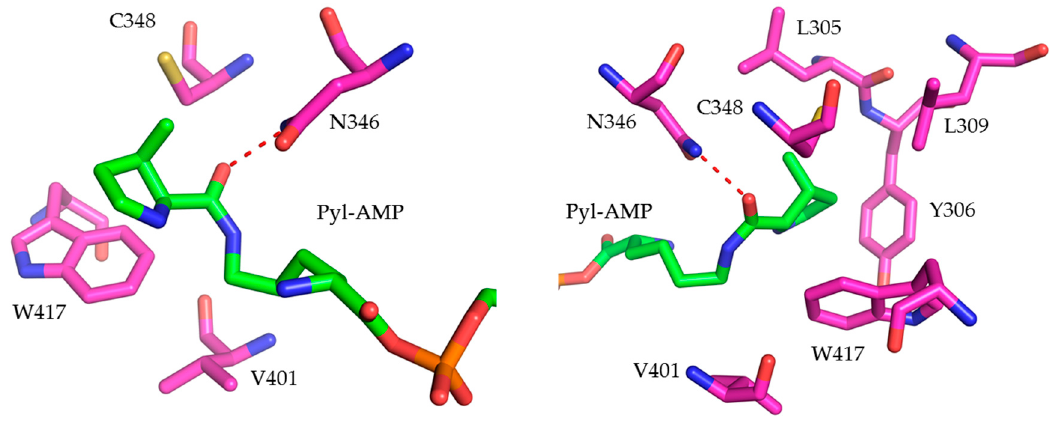
Figure 2. Key residues surrounding the active site pocket of Mm PylRS for amino acid substrate recognition (PDB: 2Q7H [10]). The distance between N346 and the bound Pyl–AMP as indicated (red dashed line) is 2.7 Å.